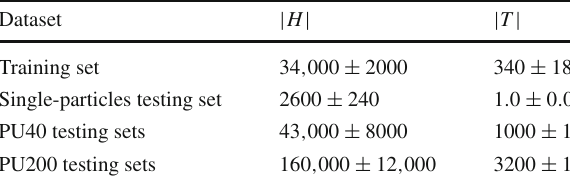
Fig. 5 Left: example of detector noise generated as described in the text. Right: example of a generated event, obtained from the overlap of 40 single-collision events and noise. The shower of secondary parti- cles generated by an individual primary particle yields a set of energy deposits in the detector labeled through markers of different colors and Table 1 Event complexity for different datasets